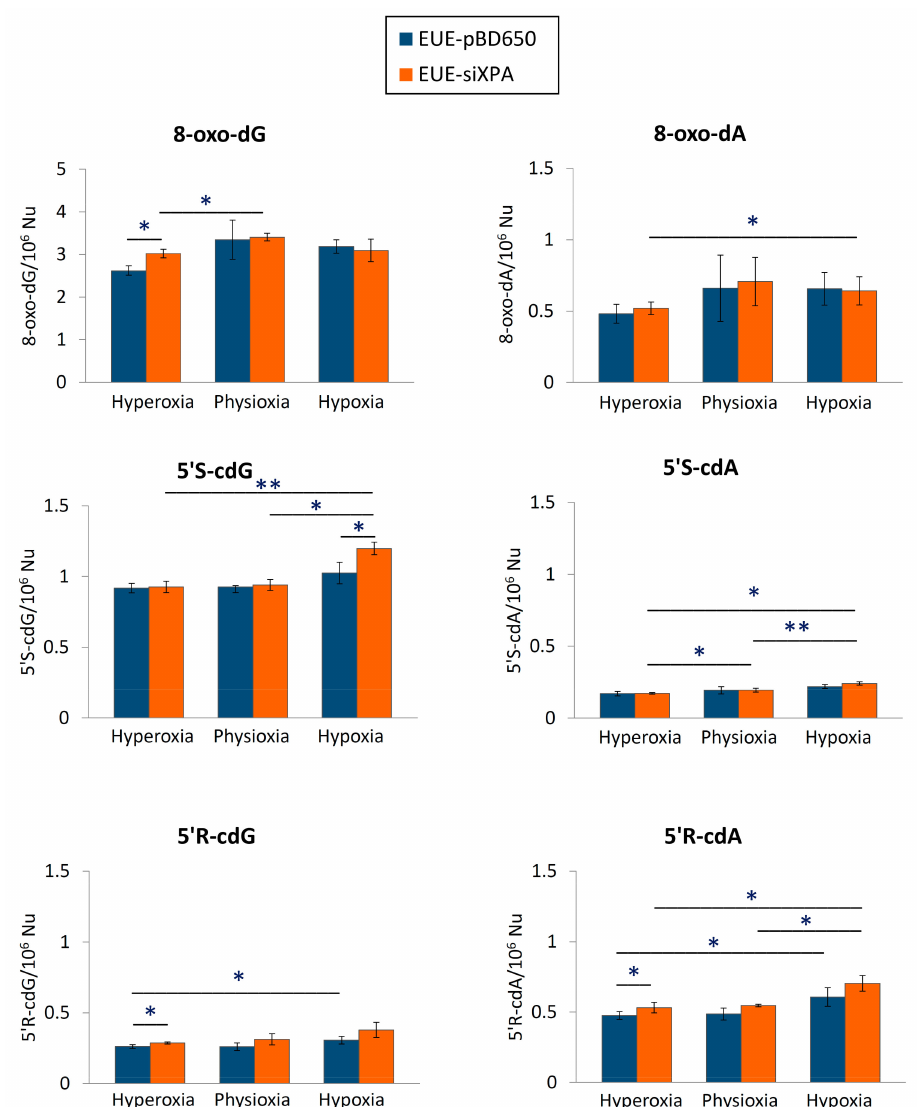
Figure 3. The levels (lesions / 10 6 nucleosides) of 8-oxo-dG and 8-oxo-dA, 5’ R -cdG, 5’ S -cdG, 5’ R -cdA and 5’ S -cdA in DNA samples isolated from EUE-pBD650 and EUE-siXPA (wt and deficient, respectively) cells in hyperoxic, physioxic and hypoxic conditions. Error bars: standard deviation of the mean, calculated from three independent samples, *: statistically significant di ff erence ( p < 0.05) between the groups, **: statistically significant di ff erence ( p < 0.005) between the